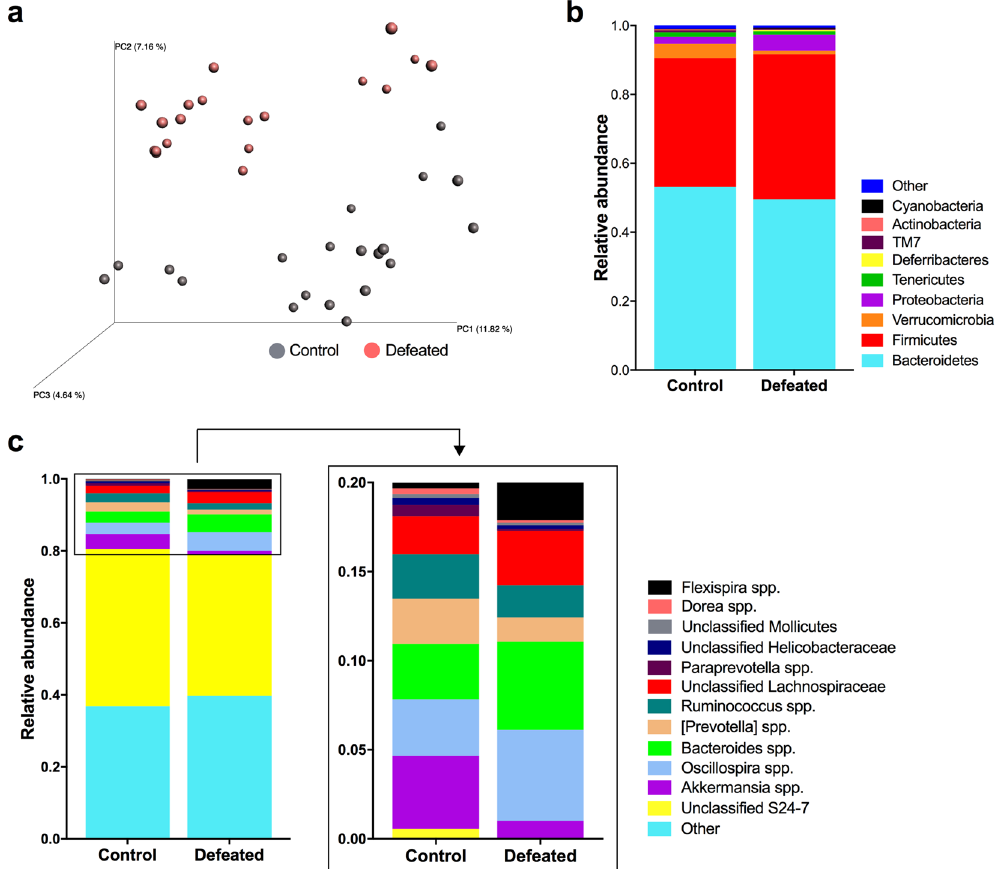
Figure 2. Exposure to chronic mild social defeat stress induces shifts in microbial communities and alters the abundance of relevant taxa. ( a ) Principal coordinate analysis of the bacterial communities among the control (gray) (n = 19) and defeated (red) (n = 20) mice. Fecal samples were collected 24 hr after the social interaction test, which immediately followed social defeat or the control condition. ( b ) Relative abundances of the bacterial communities at the phylum taxonomic rank among the control and defeated mice. ( c ) Representative graphs of the relative abundances of the bacterial communities at the genus taxonomic rank among the control and defeated mice. Defeated animals showed decreases in Akkermansia spp. (light purple), [ Prevotella ] spp. (tan), Ruminococcus spp. (dark green), Paraprevotella spp. (dark purple), unclassified Helicobacteraceae (dark blue), Dorea spp. (pink), and Mollicutes (gray) as well as increases in Oscillospira spp. (light blue), Bacteroides spp. (light green), unclassified Lachnospiriaceae (red), and Flexispira spp. (black).